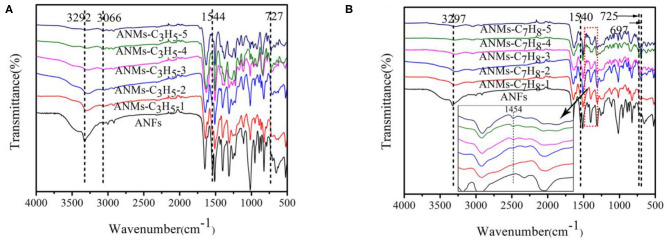
FTIR spectra of ANMs-C3H5-X (A) and ANMs-C7H8-X (B) samples.